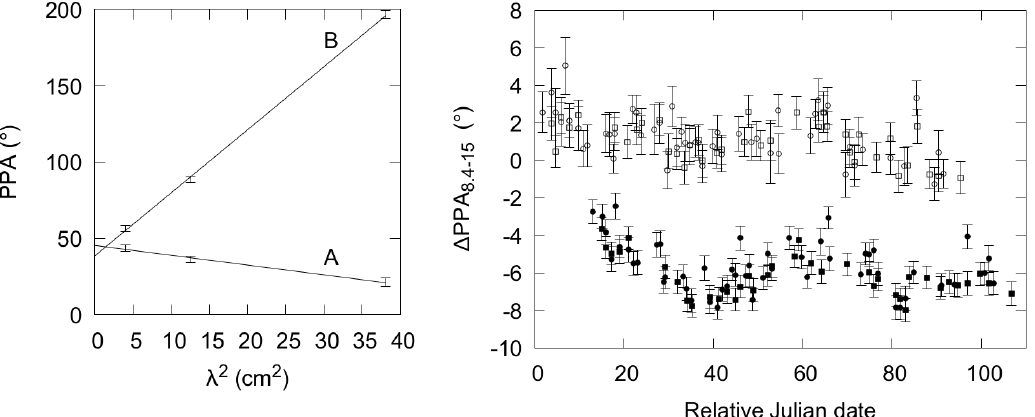
Figure 4. Left : the PPA of images A and B as a function of the wavelength squared. The linear variation is characteristic of Faraday rotation. Right : difference in PPA (8.4–15 GHz) for A (bottom—solid points) and B (top—open points). Image A has been shifted forward by the time delay. The majority of the image-B rotation measure have been removed in order to compare the two curves more